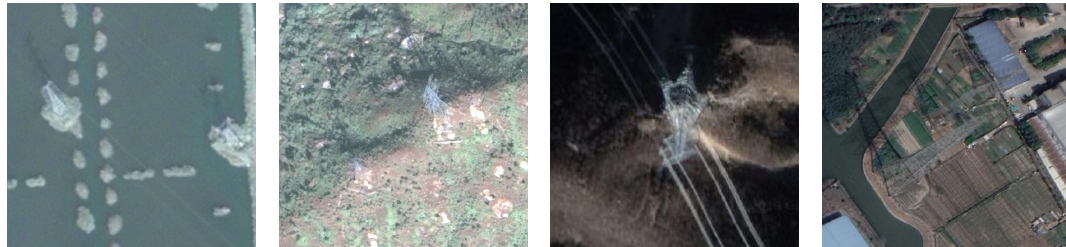
Figure 2. Image samples in our EPD dataset. The first and second images were captured by Pleiades satellite, while the third image and fourth images were collected from Google Earth. All image samples in our dataset were obtained from these two sources and image formats are all processed multi-spectral image